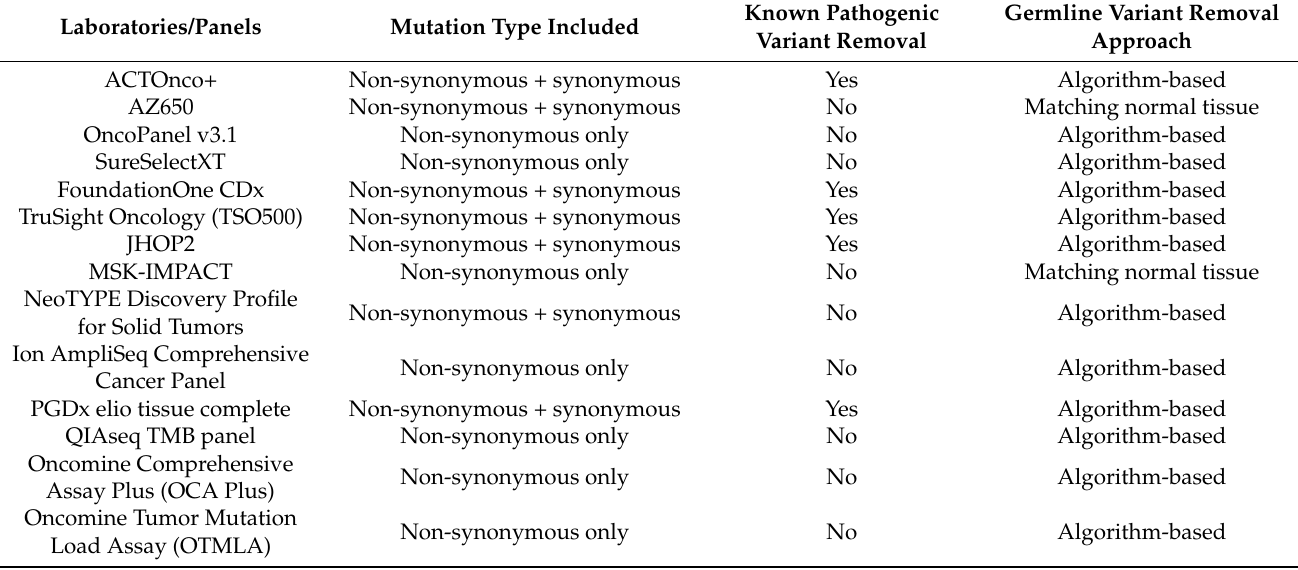
Table 3. Bioinformatics strategies in TMB